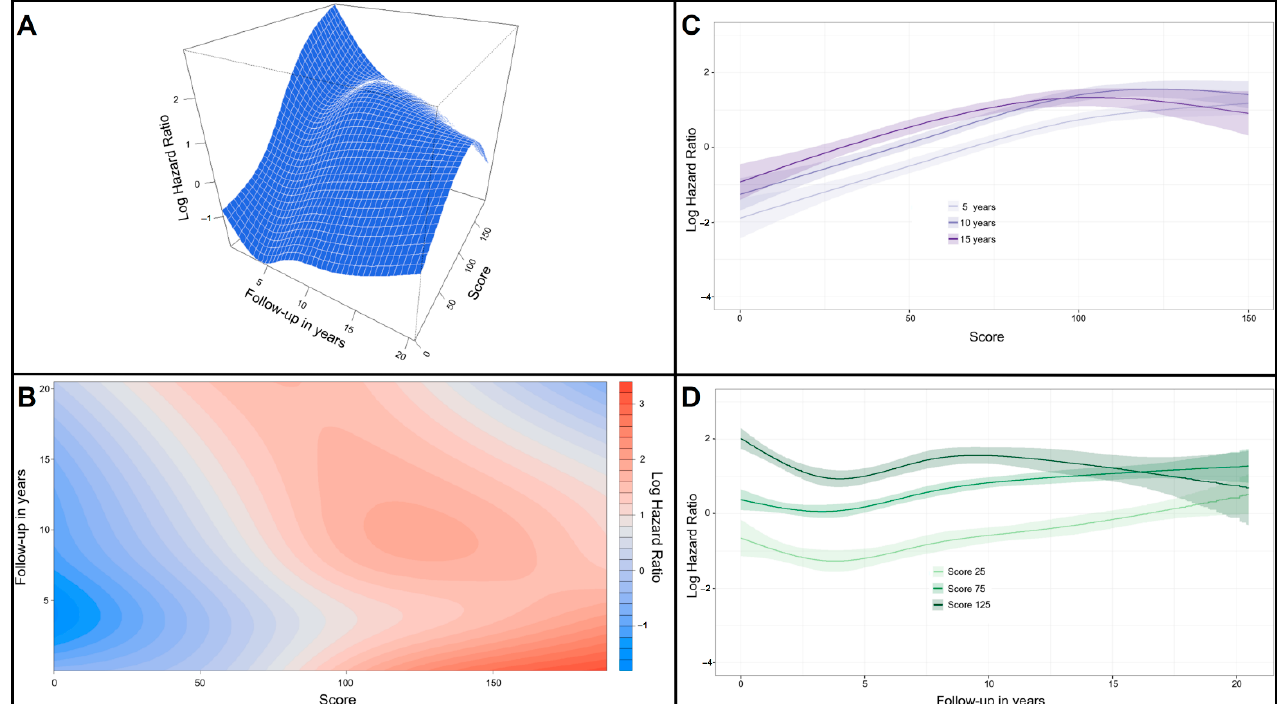
Figure 2. Three ‐ dimensional surface plots, contour maps and representative slices for fixed values of the score and fixed time points showing the time ‐ varying effect of the score. ( A ) Three ‐ dimensional surface plot showing the relation between the score and follow ‐ up time on the y ‐ and x ‐ axes, respectively. The z ‐ axis shows the contribution of each combination on the log hazard ratio for all ‐ cause mortality. ( B ) Contour map that uses a color gradient to visualize the effect of the combination on the log hazard ratio, where the darker shades of red denote an increase in the log hazard ratio. ( C ) Representative slices at fixed time points of 5, 10 and 15 years of the follow ‐ up. The score and the log hazard ratio are shown in x ‐ and y ‐ axes, respectively. ( D ) Representative slices at fixed values of the score at 25, 75 and 125 points. The follow ‐ up in years and the log hazard ratio are shown in x ‐ and y ‐ axes, respectively.